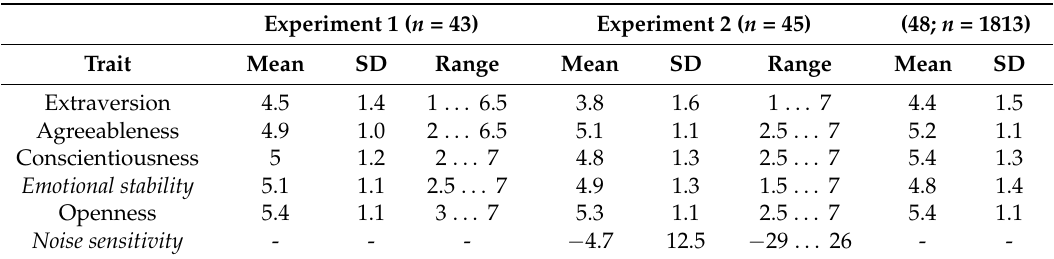
Table 5. Personality characteristics of participants in Experiment 1 and 2, compared with normative data published by Gosling et al.